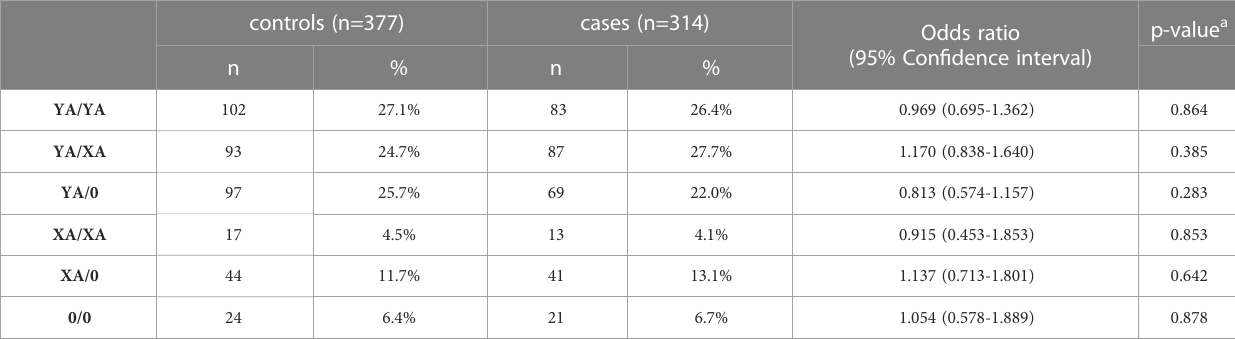
TABLE 2 Frequencies of short MBL2 haplotype combinations in healthy controls and cases (merged COVID-19 cohorts (CAM+BUD).